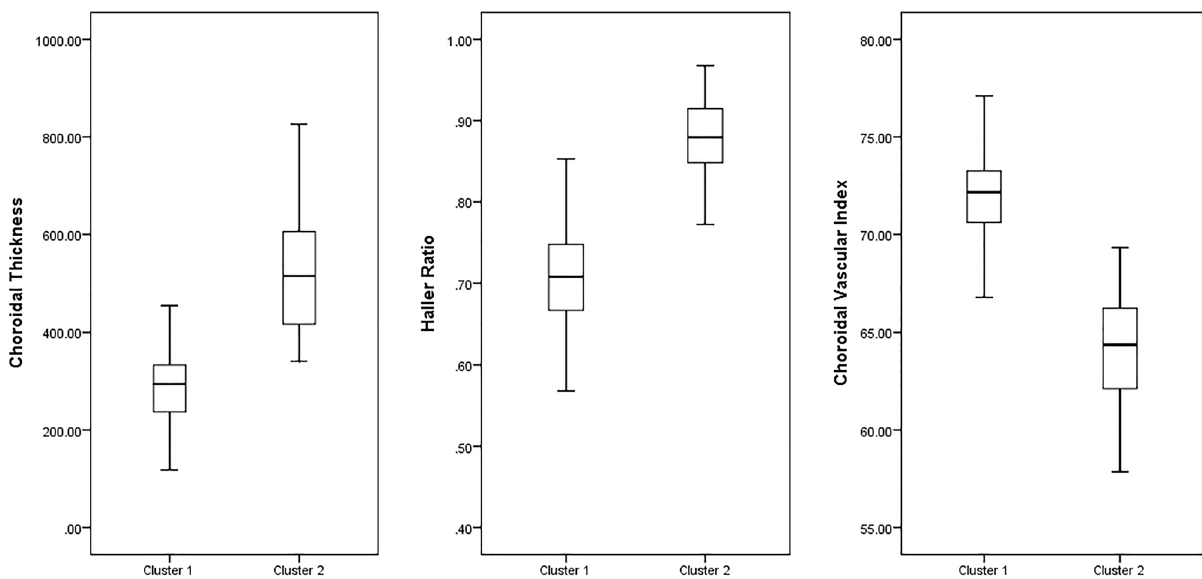
Figure 4. The box and whisker plot of the difference in input variables of TwoStep cluster analysis between cluster 1 and Table 4 summarizes the demographic findings and the details of choroidal quantifications in the testing dataset.